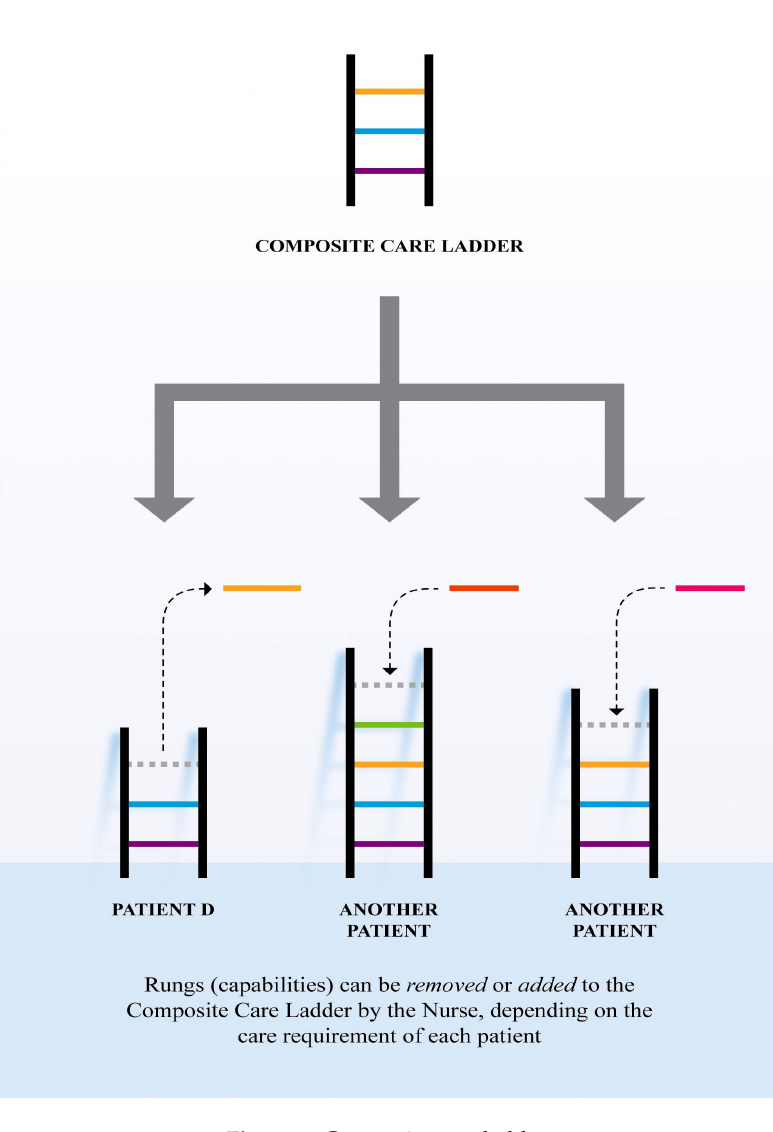
Figure 3. Composite care ladder.